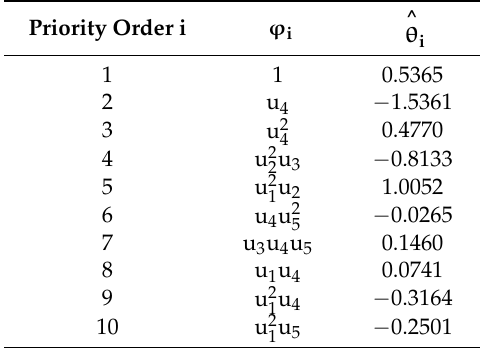
Table 2. TSP emissions model with the 10 most significant